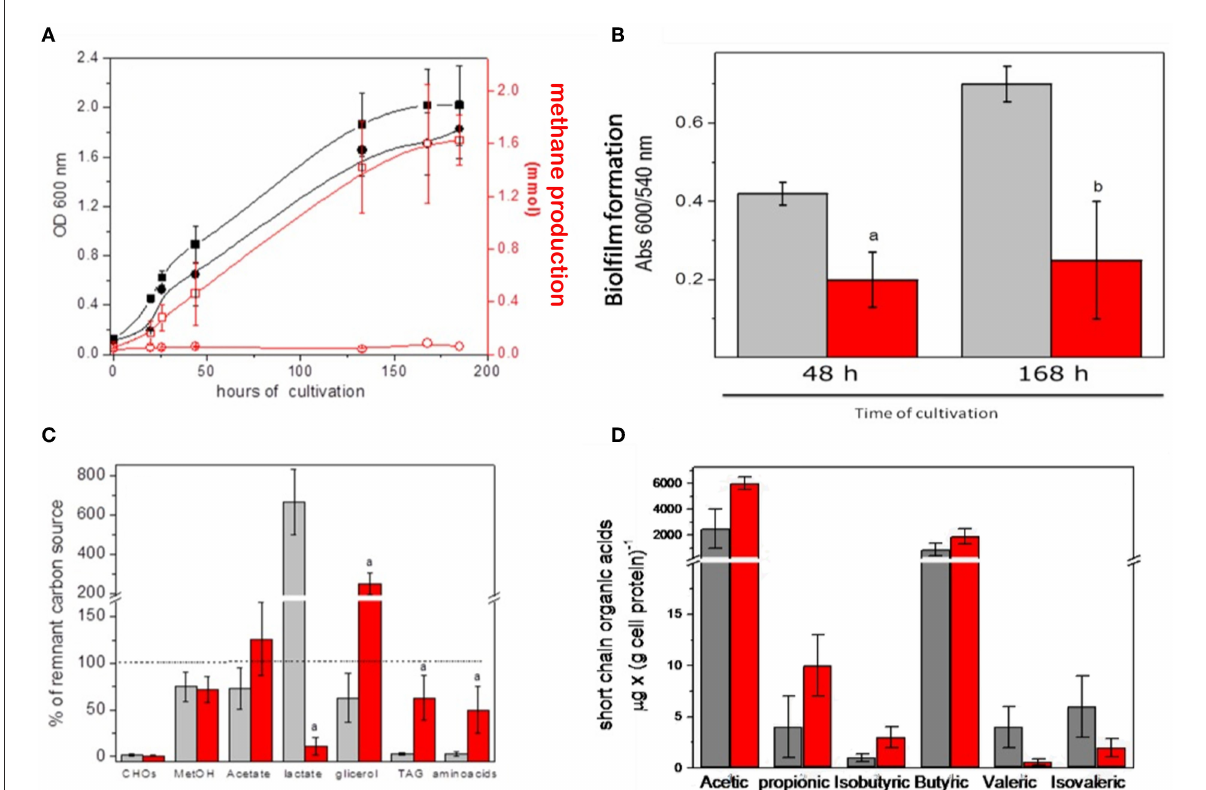
FIGURE3 Gastrointestinal microbiota cultured in the INC-07 medium. (A) Growth curves and methane formation, (B) biofilm synthesis, (C) carbon source consumption, and (D) SCOAs excreted to the culture medium. CRC growth (black squares), methane production (open squares), HRC growth (red circles), and methane production (open circles) were determined throughout time. CRC are given in gray columns and HRC in red columns. Values are the mean ± SD of five different cultures. a P < 0.001 vs. control samples. b P <